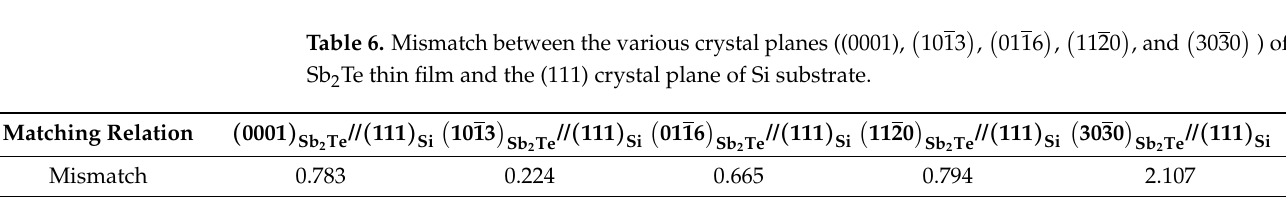
(cid:0) (cid:1) (cid:0) (cid:1) (cid:0) (cid:1) (cid:0) (cid:1) 1013 , 0116 , 1120 , and 3030 ) of